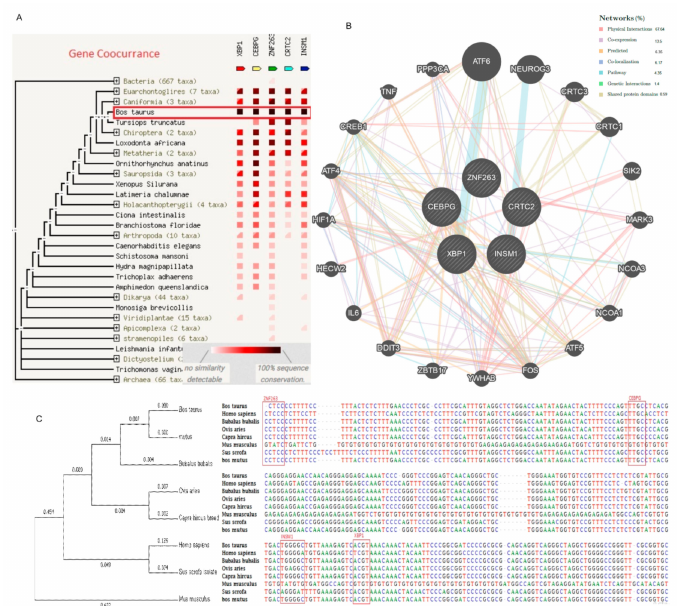
Figure 6. Genetic interaction and detailed phylogenetic tree with sequence alignment of the TORC2 gene and selected transcription factors within the promoter region of di ff erent animals. ( A ) Gene co-occurrence of TORC2 gene with C / EBP γ , XBP1 , INSM1 and ZNF263 transcription factors in Bos taurus . The color denotes—for each gene of interest—the similarity of its best hit in a given STRING genome. Similarities in these presence / absence profiles can predict interactions among target genes. ( B ) Interaction among the target genes (shown in the center). ( C ) Phylogenetic tree and multiple sequence alignment analysis of TORC2 promoter region ( − 300 bp) for ZNF263 , C / EBP γ , INSM1 and XBP1 transcription factor binding sites in cattle, human, water bu ff alo, sheep, goat, house mice, pig and wild yak. Selected transcription factor binding site sequences were found conserved in cattle, human, water bu ff alo, sheep, goat, pig and wild yak. However, variation was found in the DNA sequence of house mice as compared with other